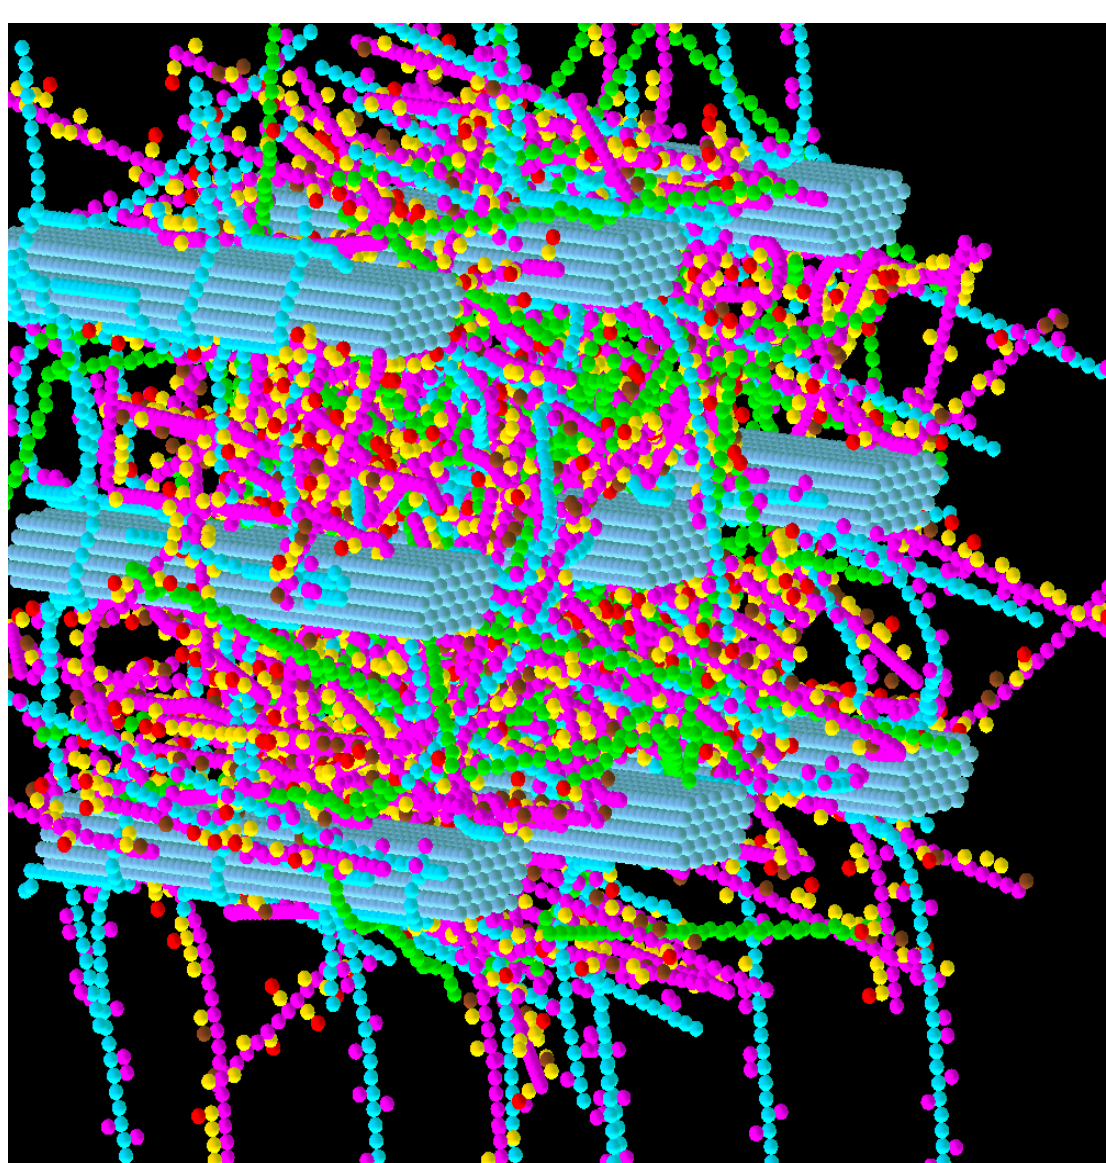
Figure 4. Free-floating GAXs and pectins (homogalacturonans) were inserted into the first hemicellulose networks to complete the model. Glucose, xylose, arabinose, glucuronic acid, ferulic acid and galacturonic acid are represented by spheres coloured blue, magenta, yellow, brown, red and green